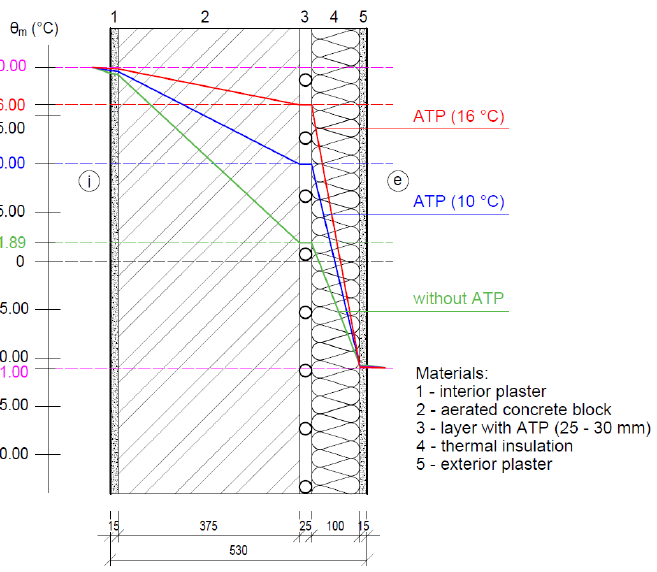
Figure 26. View of the ATP formed by a plastic pipe between aerated concrete masonry and polystyrene. θ m —the temperature in construction (°C).